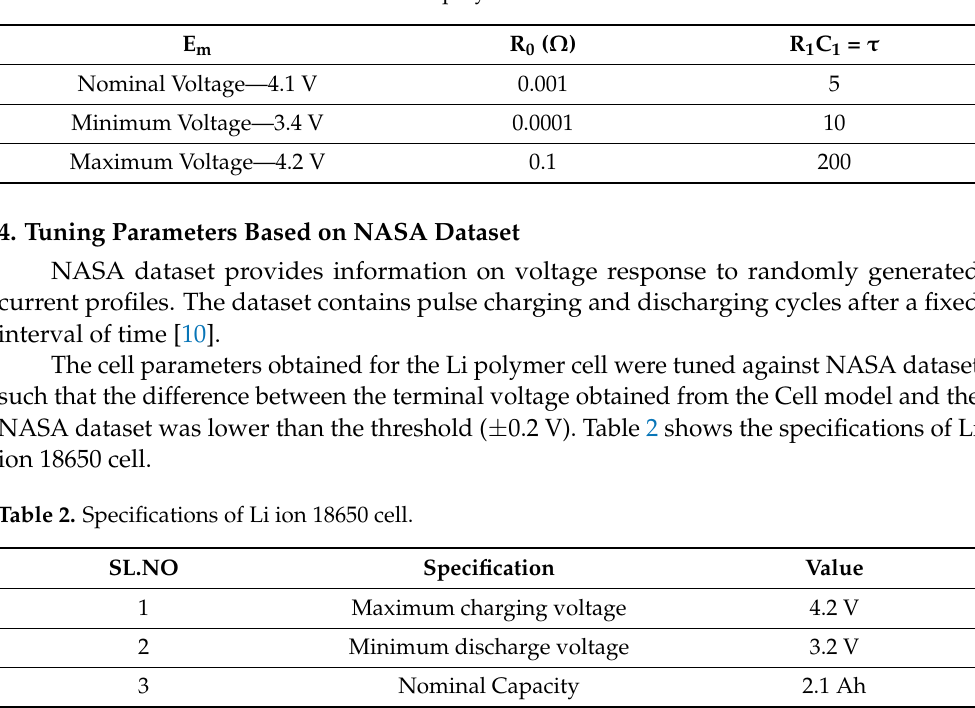
Table 1. Initial ECM estimates for a 10 Ah Li polymer cell.